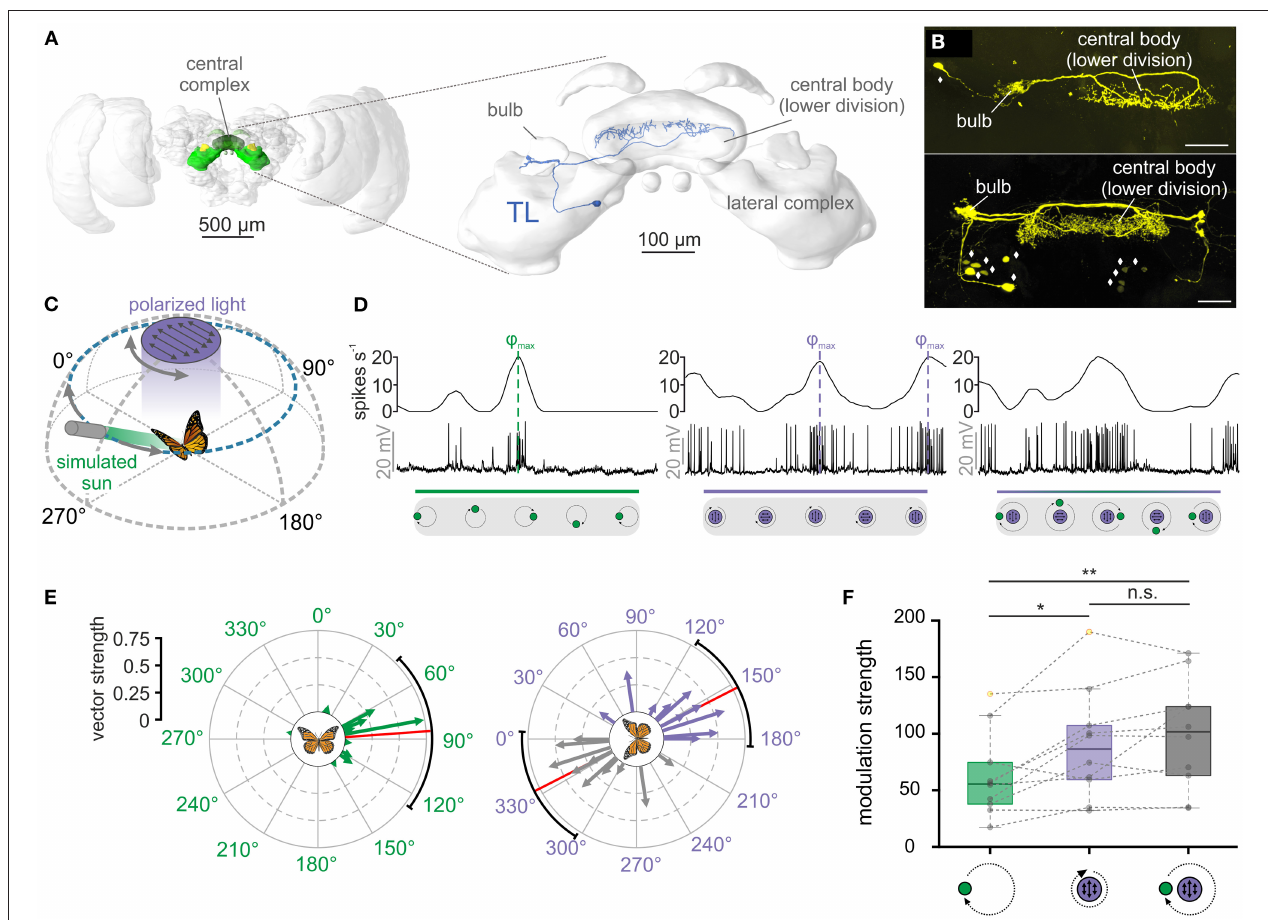
FIGURE 1 | TL neurons of the central complex encode simulated celestial cues. (A) Left: Frontal view of the monarch butterfly brain. Highlighted in green are the neuropils of the central complex and lateral complex. Right: The central complex and lateral complex. A reconstructed tangential neuron (TL) is shown in blue. Modified from Heinze et al. (2013). (B) Two examples of TL neuron tracings (anterior views) during electrophysiological recordings (maximum intensity projection views). While single cell tracings of one TL cell was possible (top, synaptic input in the right bulb), in most experiments, several TL neurons from both hemispheres were labeled (bottom). Diamonds indicate the position of TL neuron somata. Scale bars: 50 µ m. (C) Schematic illustration of the presented simulated celestial cues. The polarization stimulus was positioned dorsally to the butterfly and was rotated by 360 ◦ . The angle of polarization was aligned with the antero-posterior axis of the animal at the beginning of the rotation. The sun stimulus (elevation: 30 ◦ ) was moved on a circular path around the animal. The angle of polarized light was oriented perpendicular to the direction of the sun stimulus, simulating their spatial relationship in nature. (D) Neural tuning of the same TL neuron to a moving sun stimulus (left), a rotating polarizer (middle) and when both stimuli were presented simultaneously (right). The upper curve of each plot shows the sliding window average of the action potential recordings (middle row). The lower gray boxes illustrate the position of the stimuli during a clockwise 360 ◦ -rotation. Preferred firing directions ( ϕ max ) to the sun (left) and polarized light (middle) are indicated by dashed vertical lines. (E) The preferred firing directions of the tested TL neurons ( n = 10) in response to the sun stimulus (left) and the polarization stimulus (right). Each arrow represents a single neuron. Arrow length indicates the vector strength (directedness) of the neural tuning. The circular plots are labeled in relation to the animals’ body axis (see schematic at the plot’s center), with 0 ◦ being anterior, 90 ◦ being right, and 270 ◦ being left to the animal. The mean preferred firing directions (sun stimulus: 85.88 ◦ ± 54.94 ◦ ; polarized light: 152.96 ◦ ± 34.16 ◦ ) are indicated by the red solid lines and the confidence intervals (95%) by the black arcs. (F) Modulation strength of neural activity ( n = 10) in response to the sun stimulus (left), polarized light (middle), and the combination of both celestial cues (right). The neural modulation to the sun stimulus was significantly weaker than to polarized light (p GREENvs.POL = 0.02, t = 2.99, n = 10; paired t -test) and the combination of the stimuli (p GREENvs.COMBO = 0.002, t = − 4.38, n = 10; paired t -test), while the modulation strength to polarized light and the combined stimuli did not differ from each other (p POLvs.COMBO = 0.23, t = − 1.28; paired t -test). Gray circles show individual data points. Outliers are indicated in yellow. Dashed gray lines connect individual data points from the same TL neuron. Boxes indicate interquartile range. Whiskers extend to the 2.5 th and 97.5 th percentiles. Black horizontal lines show the median. n.s.: not significant, * p < 0.05, ** p <